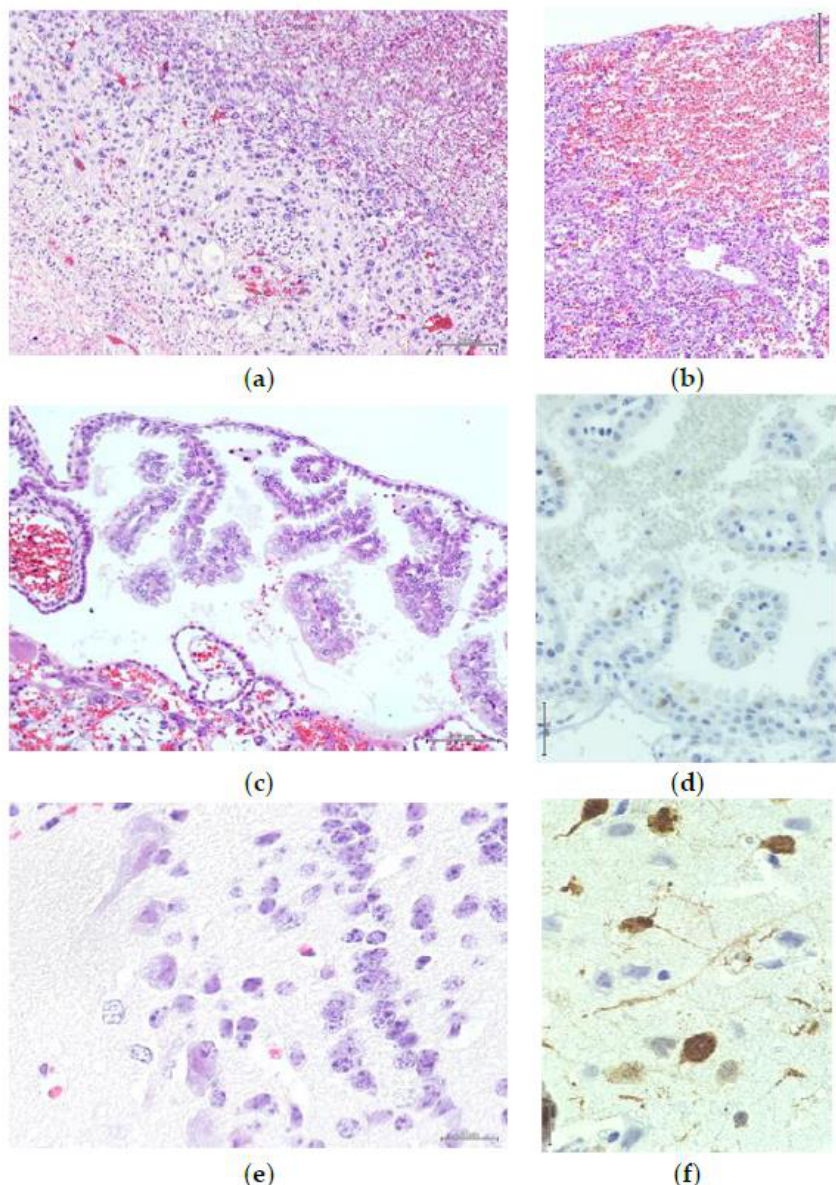
Figure 9. Placental lesions in hamsters of group 3 at 3 dpi revealed minute focal necrosis in the decidua basalis ( a ) associated with hemorrhages in the placental tissue and around fetuses ( b ). Chorionic epithelium revealed granular pale apices ( c ) positively immunostained for the Equine herpesvirus (EHV) antigen ( d ). The neurons of the olfactory bulb were degenerated and necrotic, containing eosinophilic intranuclear inclusions ( e ) that were positively immunostained for EHV antigen ( f ).